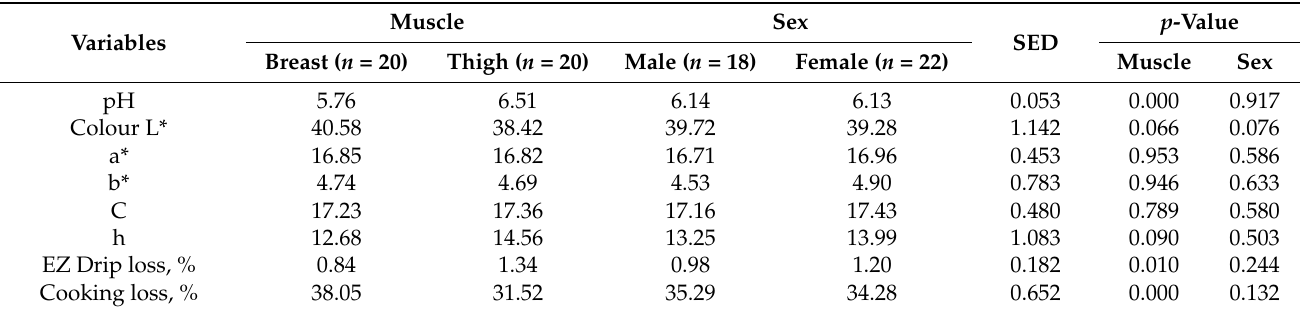
Table 5. Effects of muscle anatomical location and sex on meat quality parameters of Lithuanian Vištin˙es